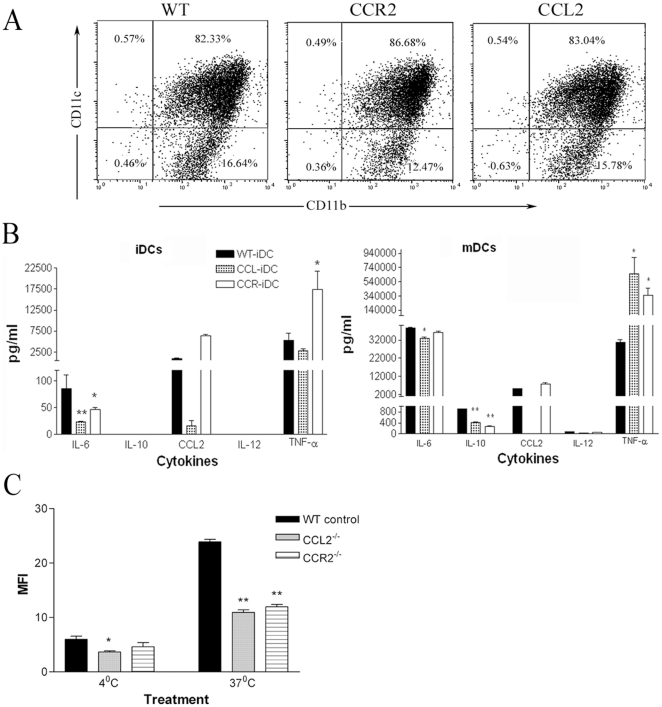
Phenotypes and functions of BM-DCs of different strains of mice.A, The expression of CD11b and CD11c in bone marrow-derived dendritic cells (BMDCs) of different strains of mice. B, cytokine production by immature BM-DCs (iDC) and mature BM-DCs (mDC) of different strains of mice. C, endocytosis of FITC-dextran by iDC of different strains of mice. Mean ± SEM, n = 4. *, P<0.05, **, P<0.01 in comparison to WT cells. n = 4, unpaired Student t test.